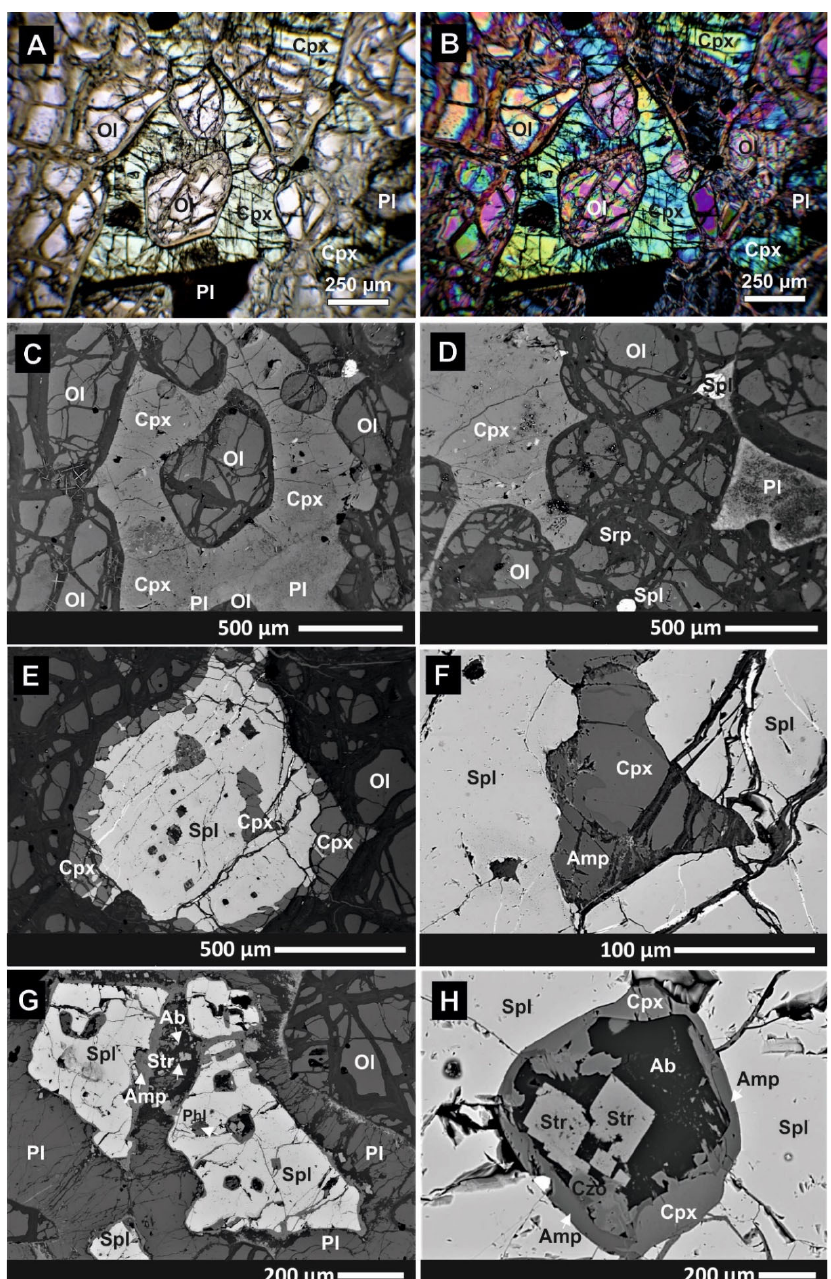
Figure 11. PL microscopic ( A , B ) and BSE ( C – H ) images from troctolite (P18A). ( A–D ) Newly formed Pl and Cpx enclosing Ol and Spl. ( E–H ) Partial replacement of Spl by Cpx (outer and inner coronas), Amp (Krs), Phl, Czo, Ab, and Str in Ab. Picture ( A ) at II P; ( B ) at X